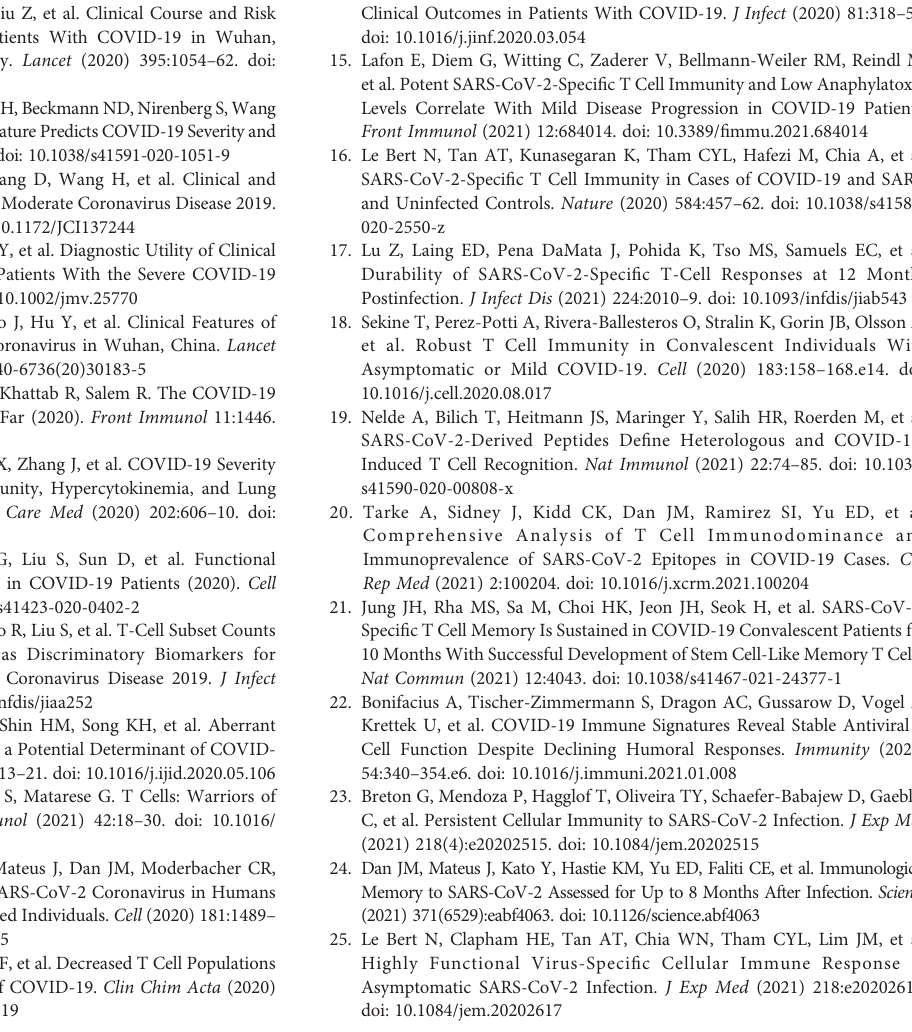
table are sorted fi rst by FDR, then by nominal p -value from least to greatest, and then alphabetically by gene ENSEMBL_ID. Counts per million reads for each gene areavailableforallsamplesincludedinthe analysis. LogFC ,log 2 transformedvalues of fold changes in gene expression between CoV2+ and CoV2- samples; FC , fold changes in gene expression between CoV2+ and CoV2- samples; FDR , false discovery rate corrected p -value; cmp , counts per million. Supplementary Table 3 | Pathways enriched for DEGs identi fi ed between CoV2 + and CoV2- groups (nominal p -value <0.05). Pathway enrichment analysis was conducted using the Database for Annotation, Visualization and Integrated Discovery (DAVID) v6.8 and KEGG and Reactome databases. Pathways with nominal p -value <0.1 were considered signi fi cant. Pathways identi fi ed from both databases were combined and sorted by the nominal p